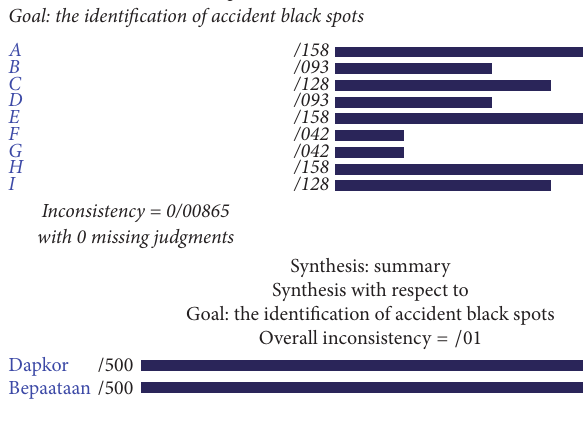
Figure 6: Section 4: Sarbaaz-Pashaamag Mortaan.